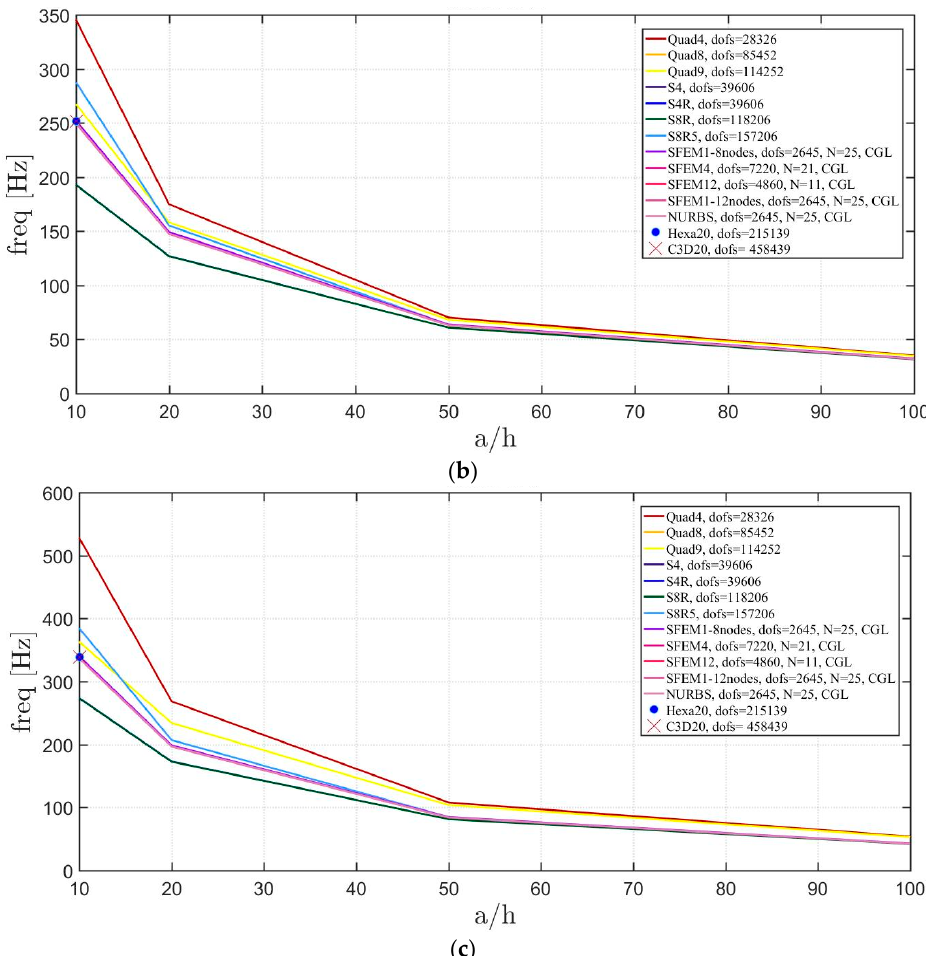
Figure 22. Thickness effect on the first three natural frequencies of a circular plate with a not-symmetric lamination scheme: ( a ) First frequency; ( b ) Second frequency; ( c ) Third frequency.